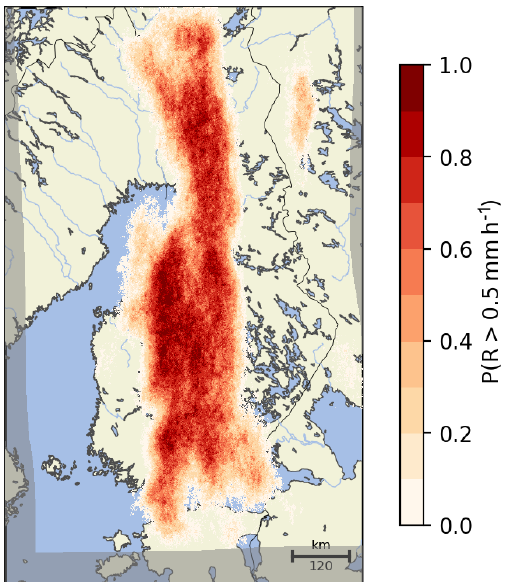
Figure 26. Probability of exceeding 0.5mmh − 1 computed from the STEPS nowcast ensemble shown in Fig. 25 with 24